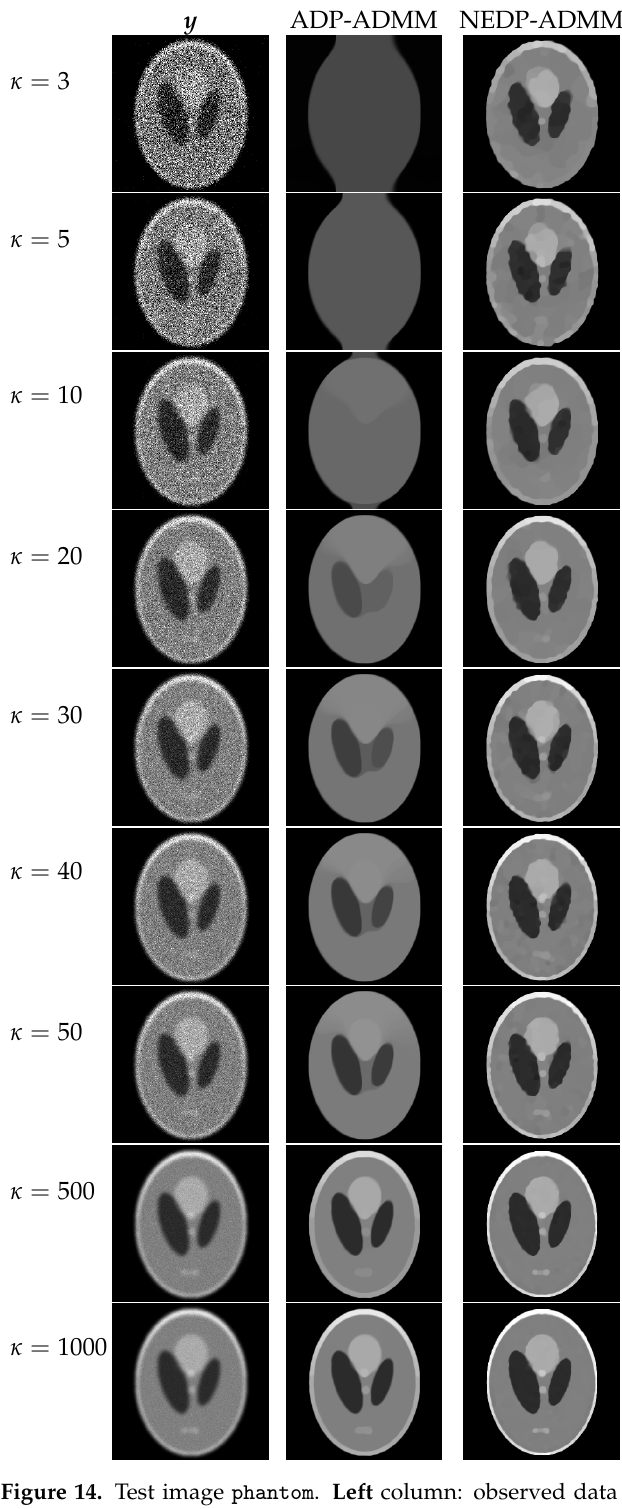
Figure 14. Test image phantom . Left column: observed data y corrupted by Gaussian blur with parameters band = 13, sigma = 3 and Poisson noise with different κ -values ranging from 3 to 1000. Middle column: restorations by ADP-ADMM. Right column: restorations by